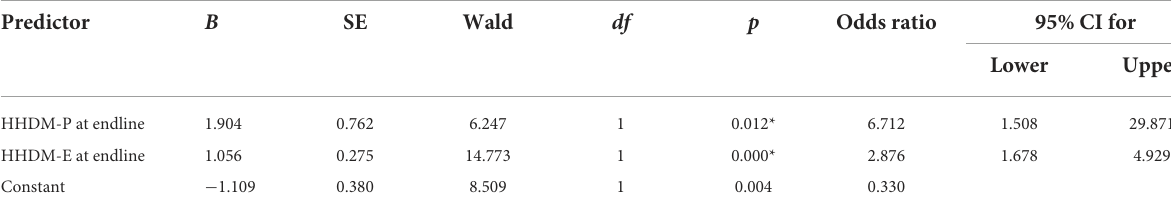
TABLE 6 Logistic regression results for empowerment adequacy based on HHDM-P and HHDM-E at endline. Logistic regression predicting empowerment adequacy based on HHDM-P and HHDM-E at endline Predictor B SE Wald df p Odds ratio 95% CI for Lower Upper